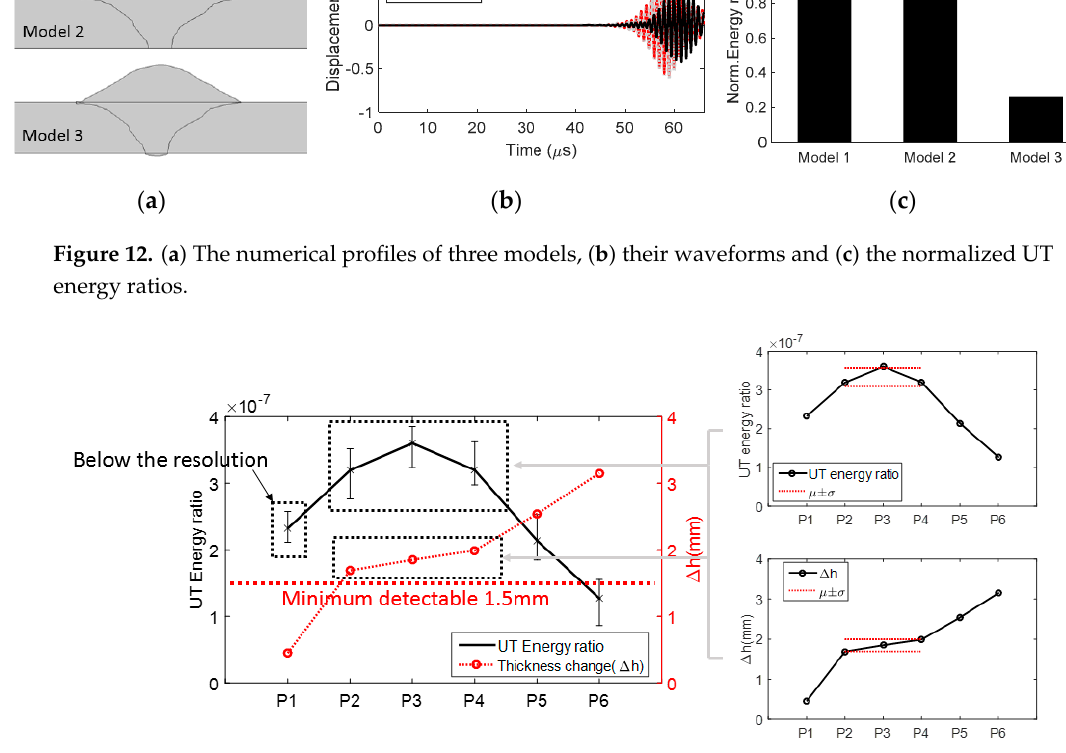
Figure 13. The correlation of thickness change and UT energy ratio.